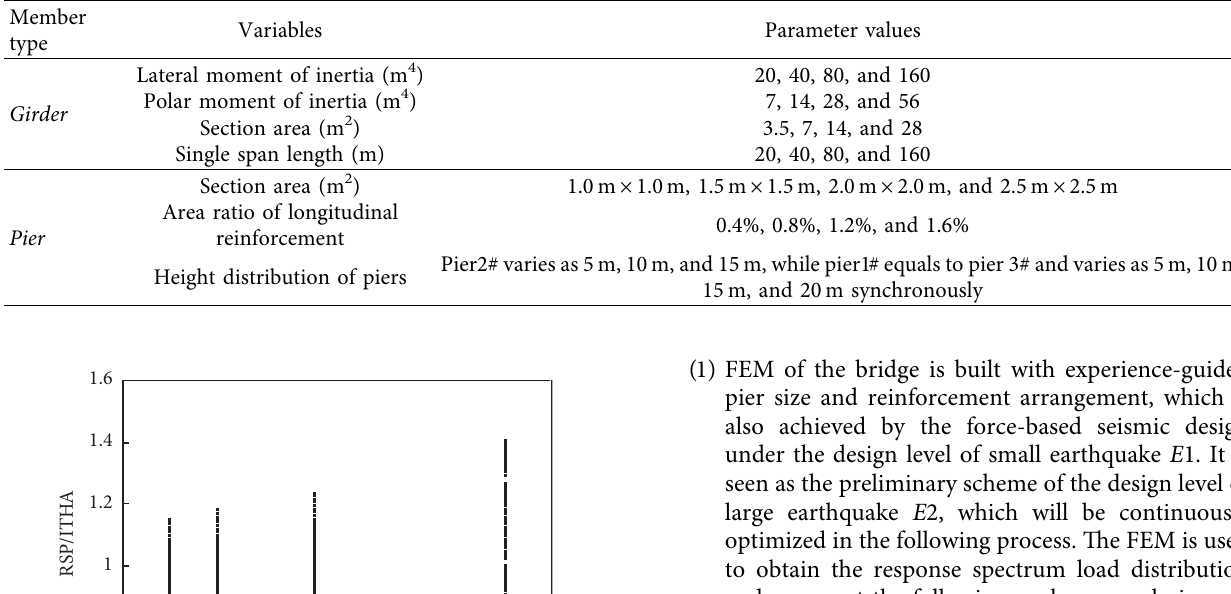
Table 2: Changing parameters of girder and piers.